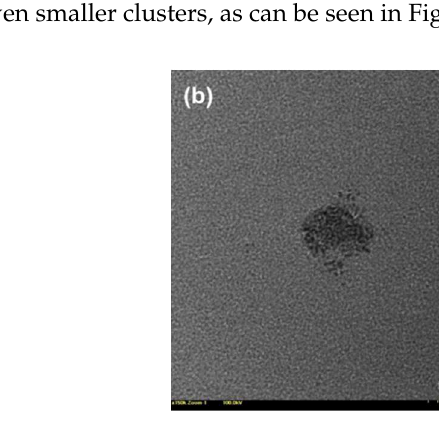
Figure 1. Recorded HR-TEM images of the carbon dots prepared from N -hydroxyphthalimide (CD-NHF): ( a ) CD-NHF with an average size of the clusters in 100–300 nm range and ( b ) CD-NHF with an average size of the smaller entities in 2–4 nm range